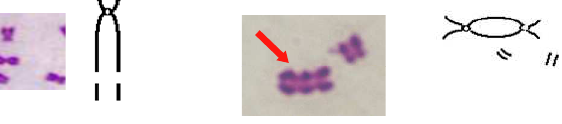
Figure 5. Chromosomal aberrations in peripheral blood lymphocytes: biomarkers of early effect and cancer risk assessment. Redrawn and modified from ref.